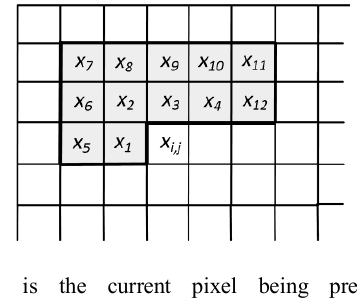
Fig. 1. x is the current pixel being predicted and , i j x is a casual template (shaded region) with